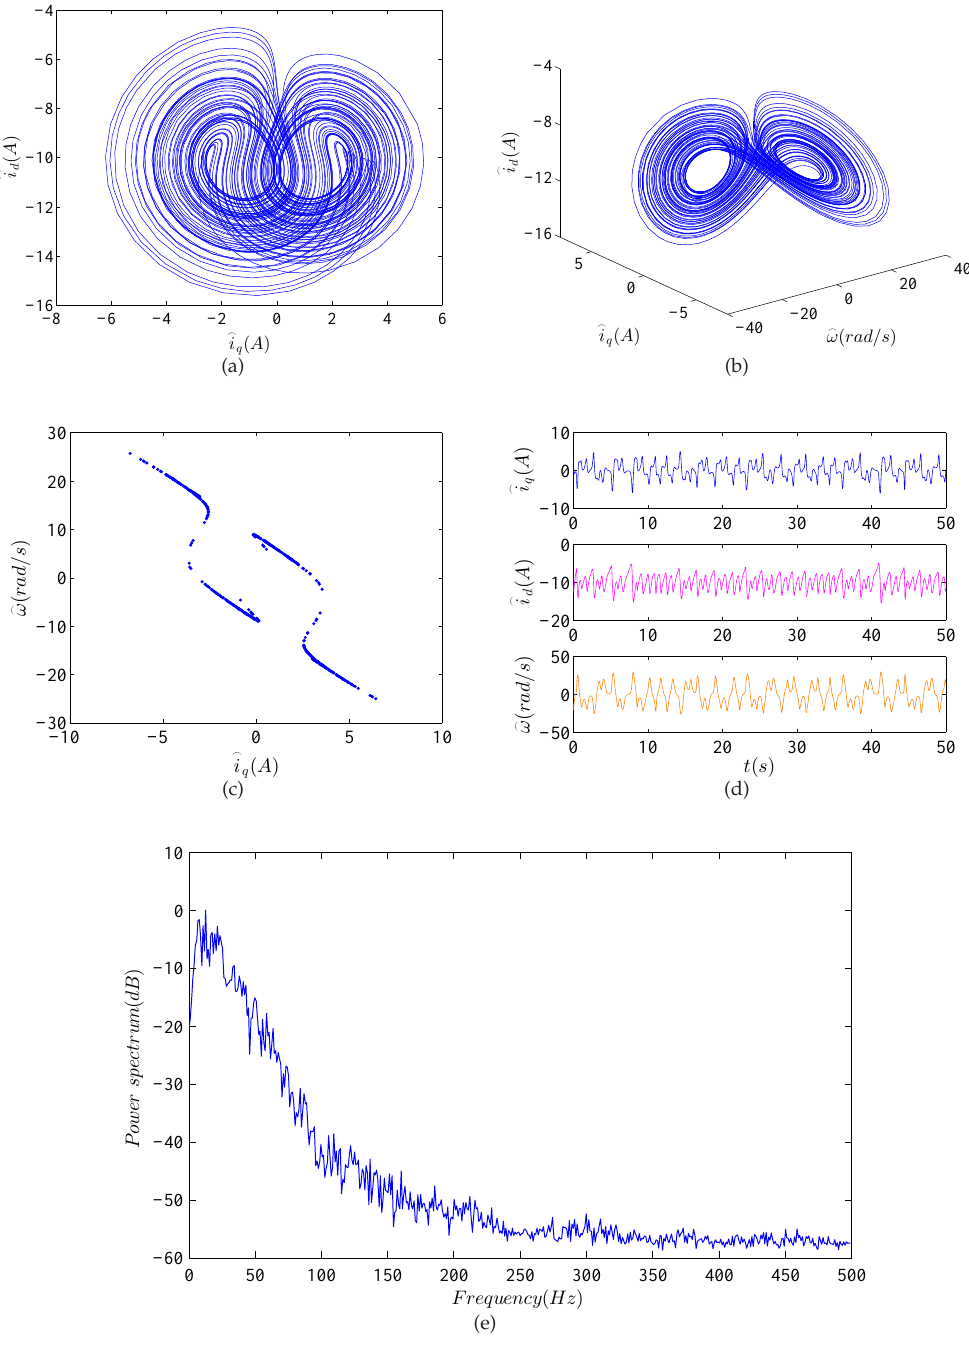
Figure 7. Numerical analysis of nonlinear dynamic behavior with ψ f = 10.5: ( a ) Phase orbit with ⌢ ⌢ i q − i d ; ( b ) Phase orbit with ⌢ ω −